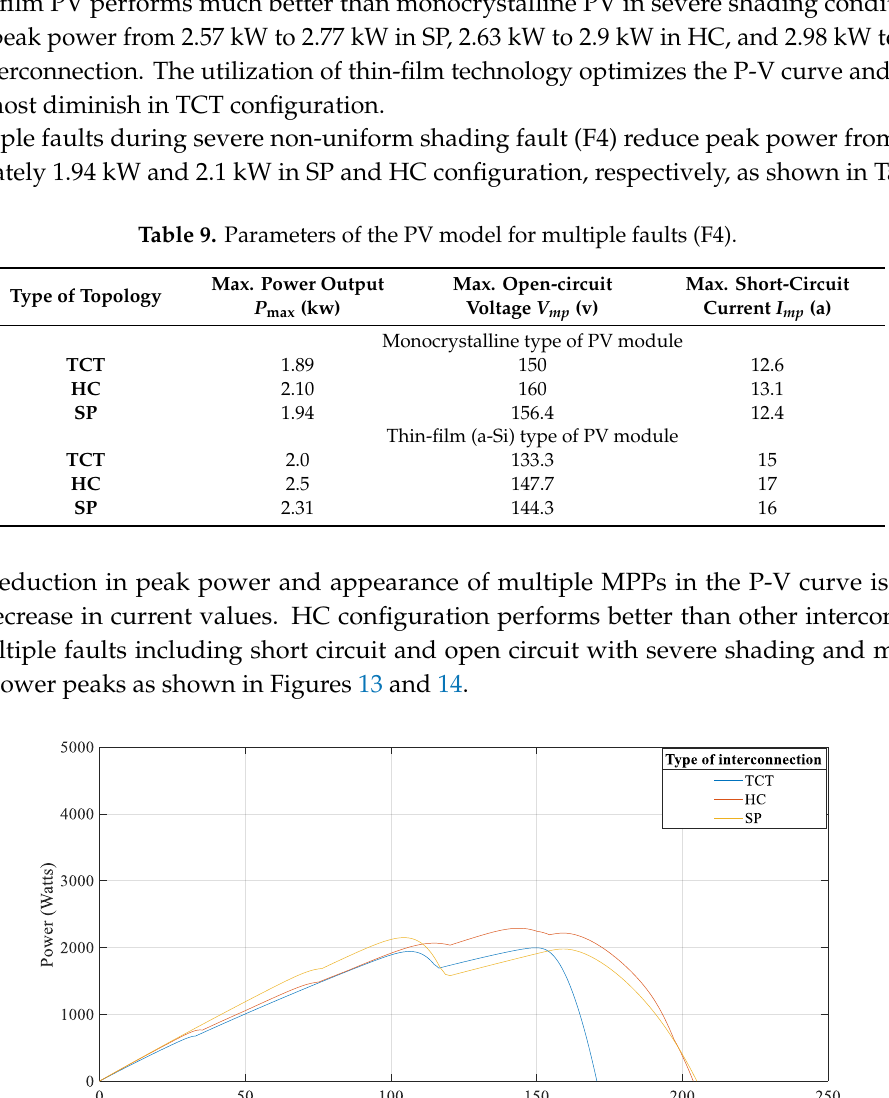
Figure 14. P-V curve for multiple faults ‘F4′ (thin-film PV). The increase in peak power from 1.89 kW in TCT to 2.1 kW in HC is observed with monocrystalline PV. Thin-film PV performs better than monocrystalline PV in the multiple fault scenario and increases peak power from 1.89 kW to 2.0 kW in TCT, 2.1 kW to 2.5 kW in HC, and 1.94 kW to 2.31 kW in SP interconnection. The utilization of thin-film technology optimizes the performance of the PV system in all fault scenarios. Thin-film PV material performs better in all fault scenarios than monocrystalline PV material according to P-V curve analysis with respect to maximum power generation. The impact of thin film and monocrystalline PV in adopted interconnections on the performance of the power grid is also analyzed for a more detailed analysis of all fault scenarios. 4.1. Impact of Faults on Power Grid The 6  6 PV array is integrated with a 25 kW grid via a DC-DC boost converter and inverter. The block diagram is given in Figure 15.